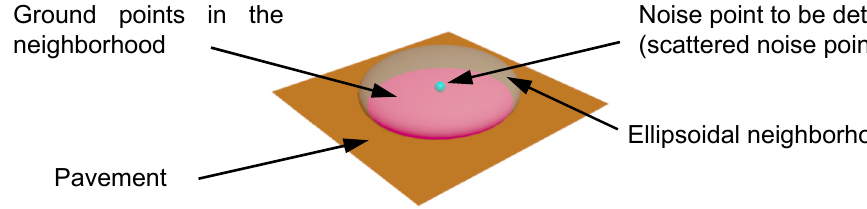
Figure 3. Ground points in the Ellipsoidal neighborhood of the scattered noise